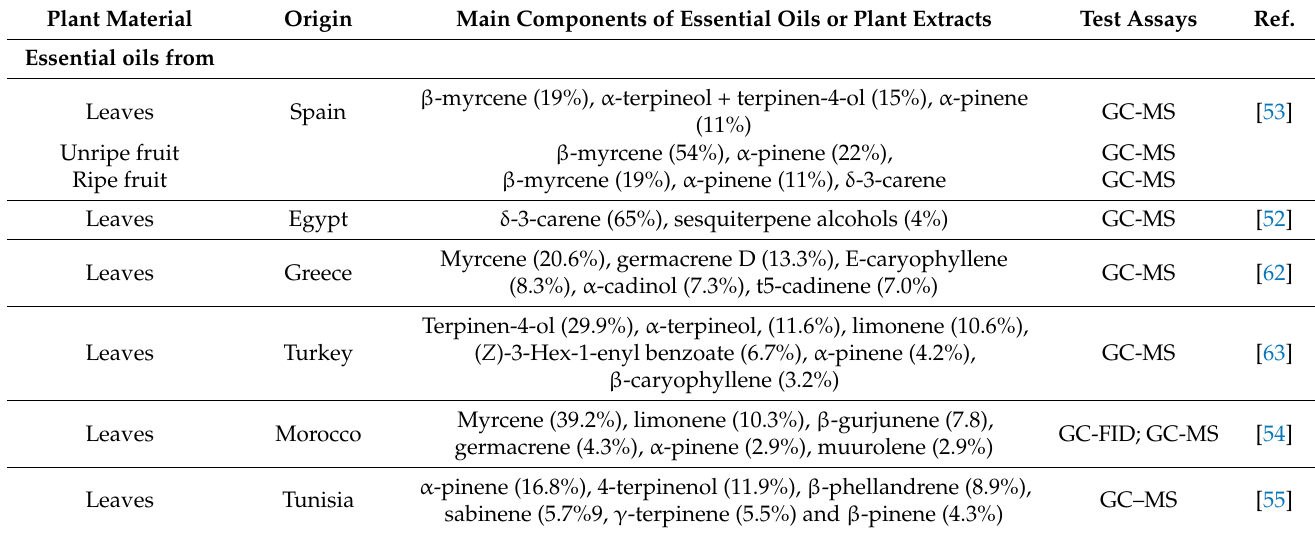
Table 3. Chemical profiles of Pistacia lentiscus